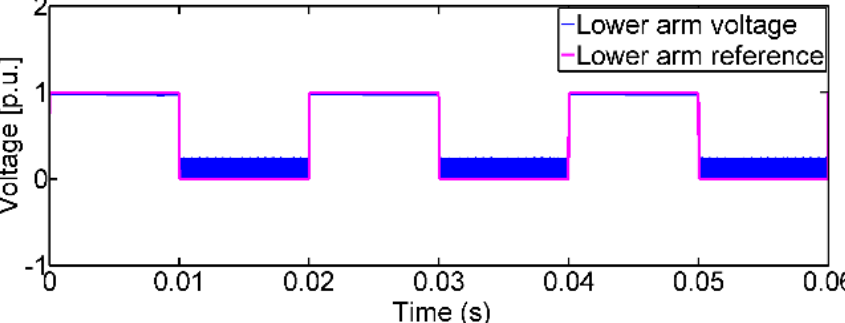
Figure 11. Trapezoidal waveform modulation of the proposed hybrid MMC when λ = 0.